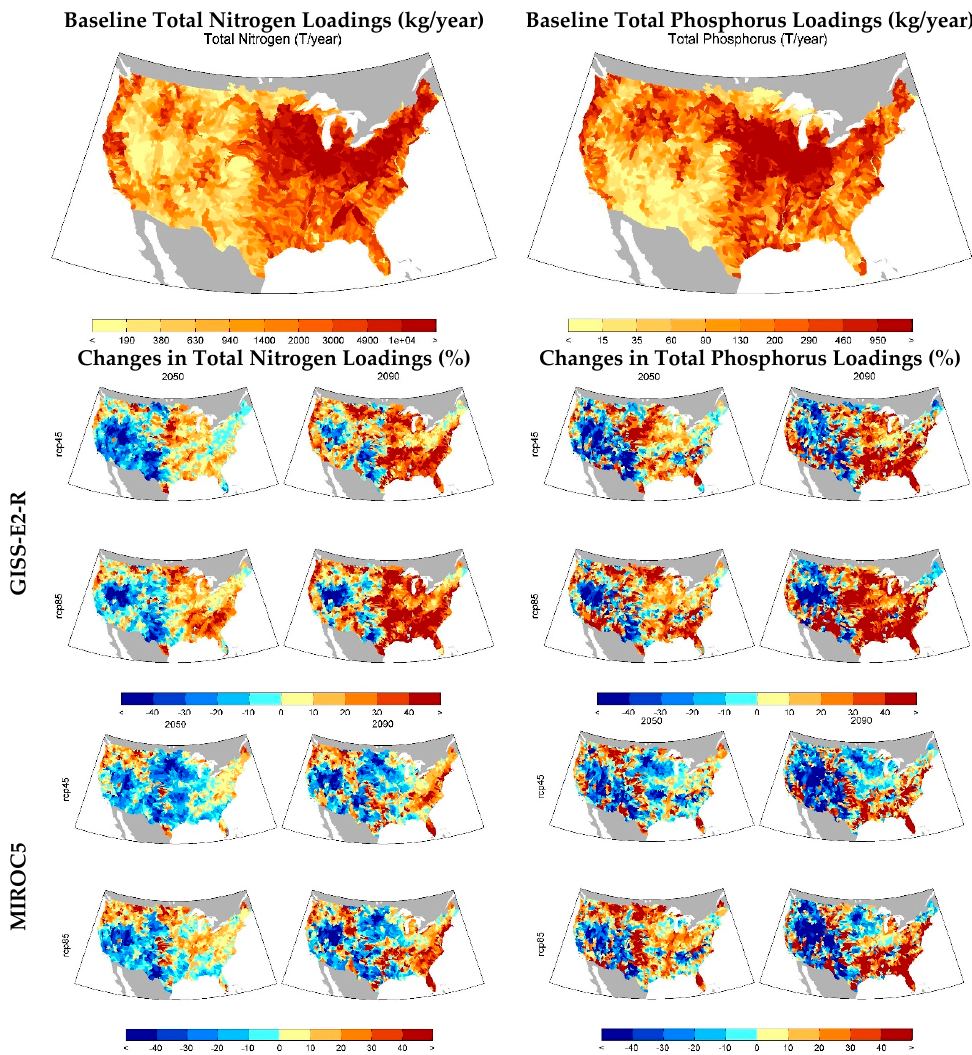
Figure 2. Non ‐ point source nitrogen and phosphorus loadings under the baseline ( top ) and climate change ( bottom ) derived from HAWQS outputs. Variability in loading patterns across climate scenarios, emissions scenarios, and time is driven by the response of the landscape model to changes in river runoff under climate change.